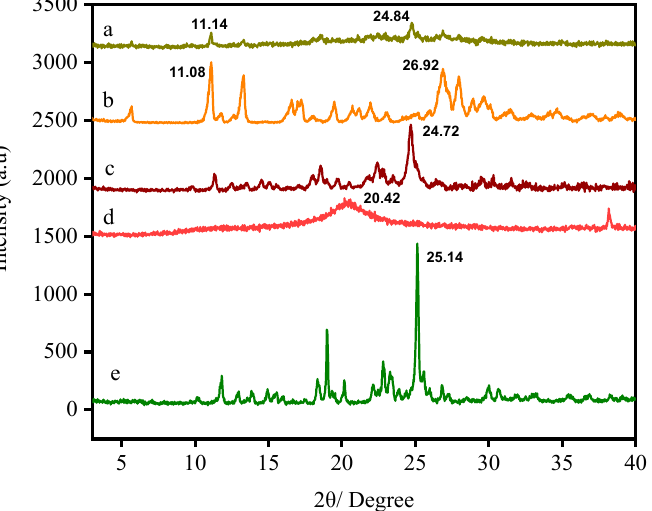
Figure 6. XRD patterns of folic acid-coated chitosan-loaded sorafenib nanoparticles ( a ), folic acid ( b ), Sorafenib-loaded chitosan nanoparticles ( c ), chitosan nanoparticles ( d ), and the drug Sorafenib ( e ).